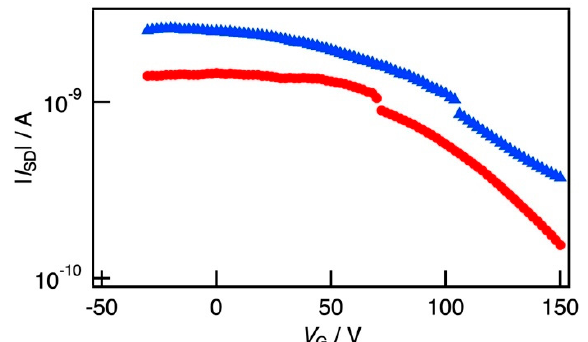
Figure 8. Transfer characteristics of the composite films of the thin SBS film loaded with the P3HT nanofiber before (red circles) and after (blue triangles) the bending deformation.